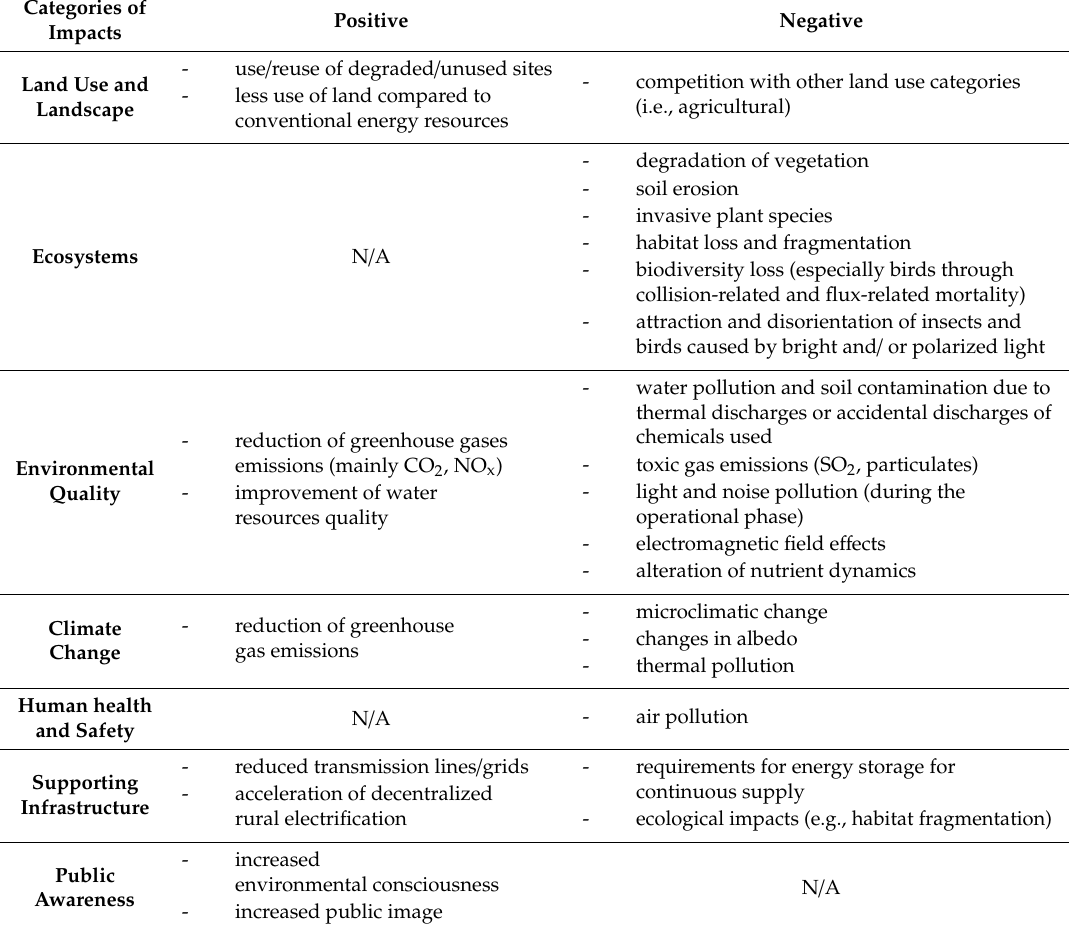
Table 1. Environmental impacts of photovoltaic